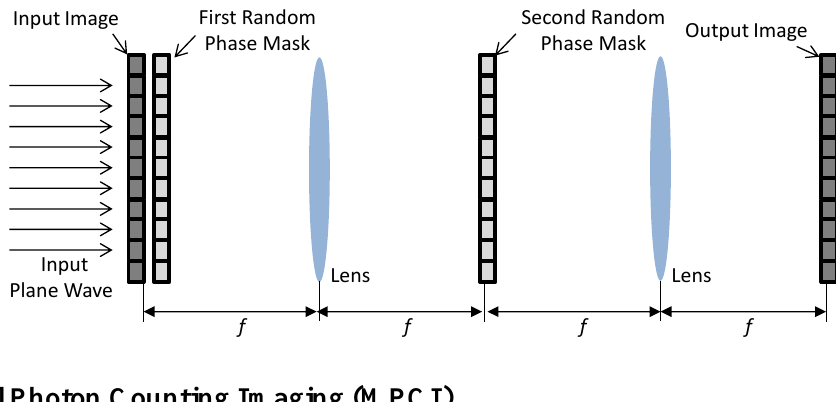
Figure 1. Schematic diagram of the DRPE system ( f is the focal length of the